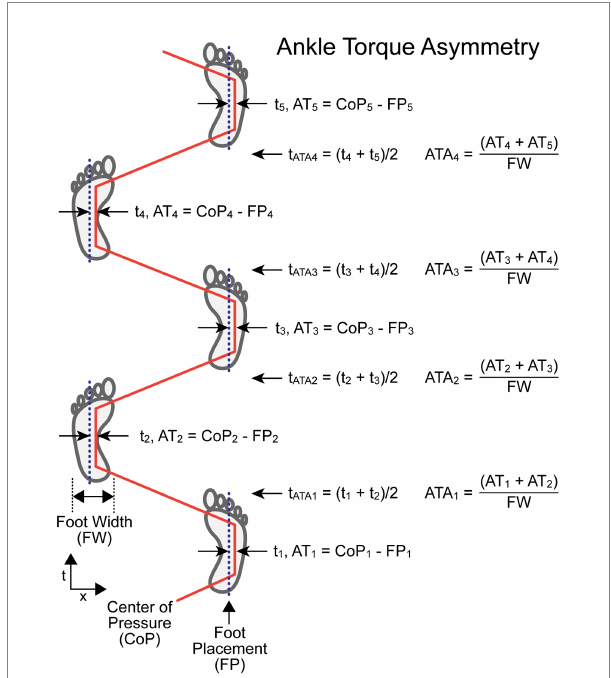
FIGURE 3 Ankle Torque Asymmetry ( ATA ) calculation parameters and